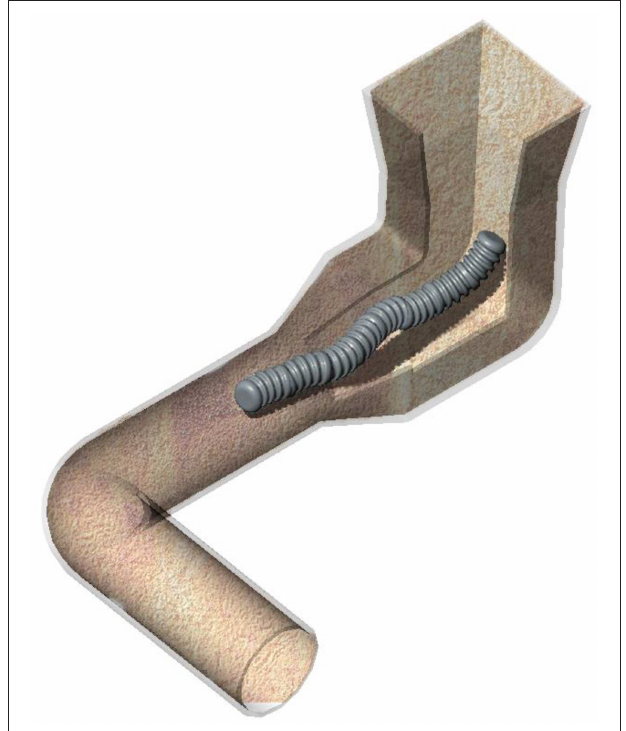
FIGURE 2 | The concept image of the search robot for pipe